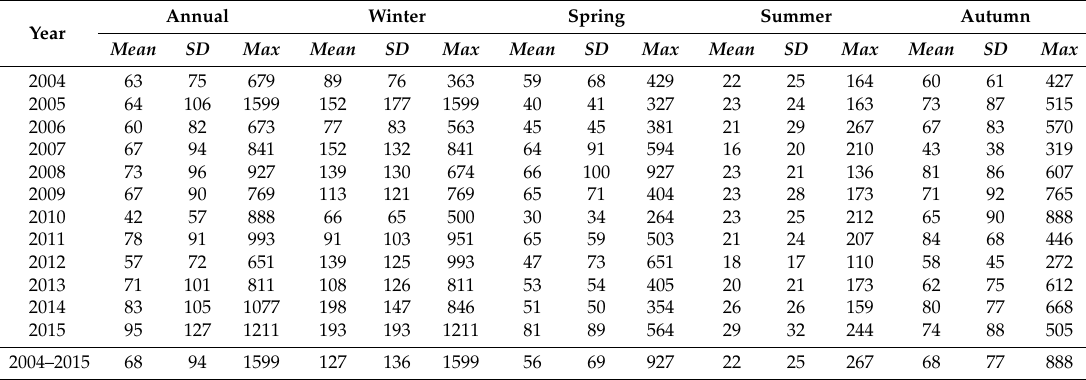
Table A9. Summary statistics from annual and seasonal analyses of P (kW/m) at BA.